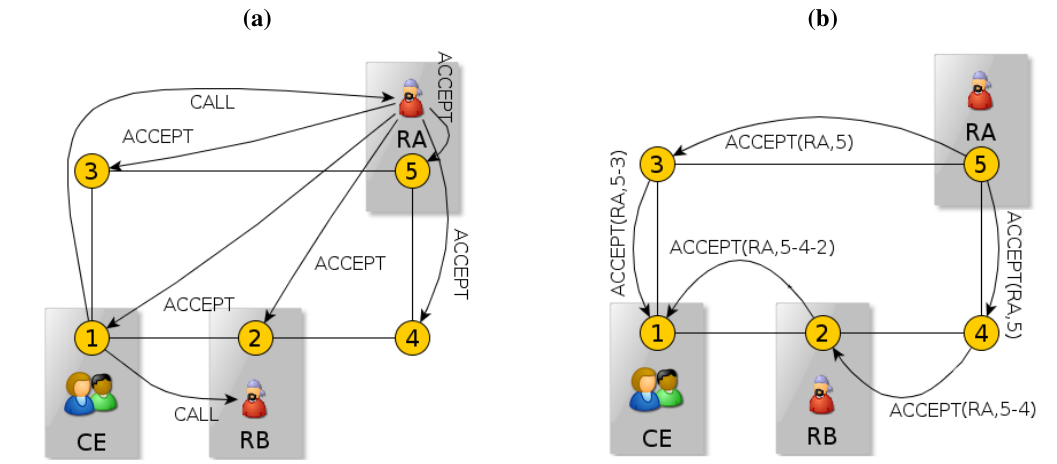
Figure 5. Distributed route planning procedure. Cameras (1–5) established their neighbourhood relationships, forming a network altogether. ( a ) Call event detection and call for robots. ( b ) Back-propagation process for route formation. See Section 5.2 for a detailed explanation.